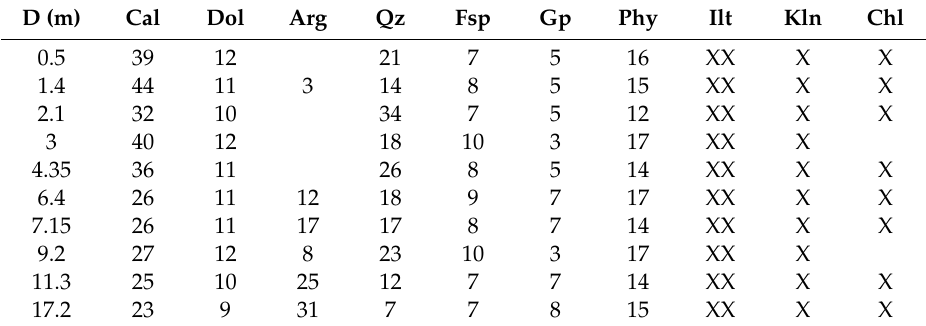
Table 5. XRD analysis of the samples along the scanline 1 in Altichuelas site in the southern segment of the Baza Fault. The distance corresponds to the distance from fault, which is also plotted on the x-axes of the plots in Figure 10.